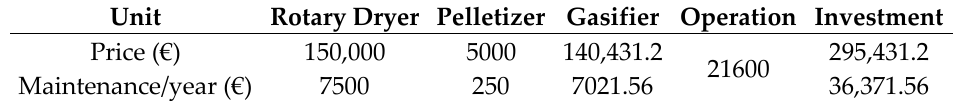
Table 4. Costs involved in the acquisition and maintenance of the sludge energy recovery